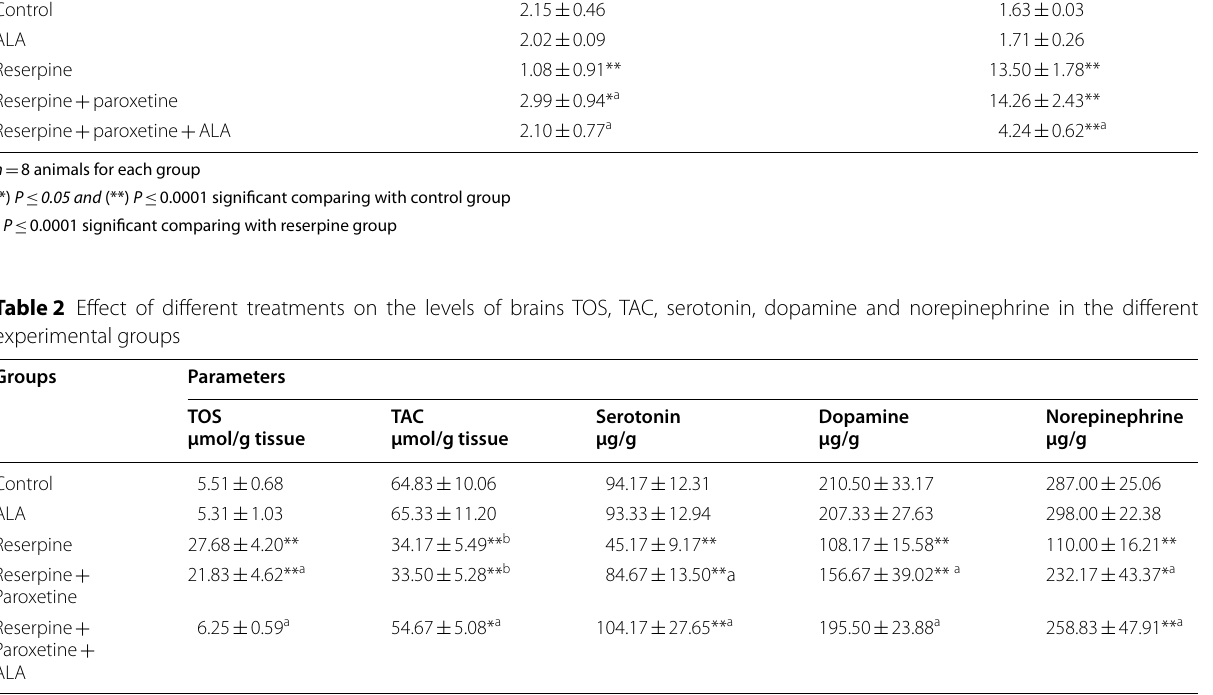
Table 1 Percentage area of PCNA and caspase-3 expressions in the cerebral cortex of rats in the different experimental groups